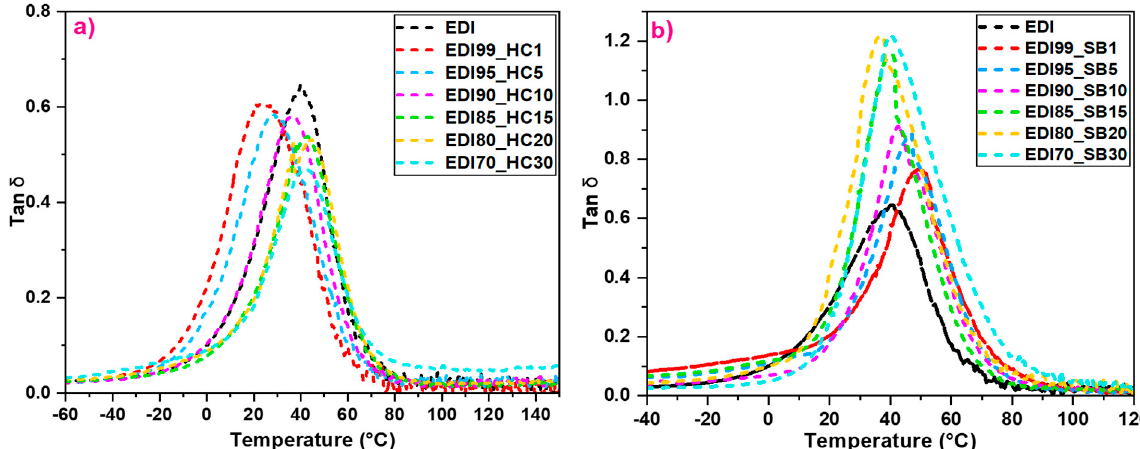
Figure 6. Damping factor as a function of temperature for ( a ) HC-based materials and ( b ) SB-based materials.